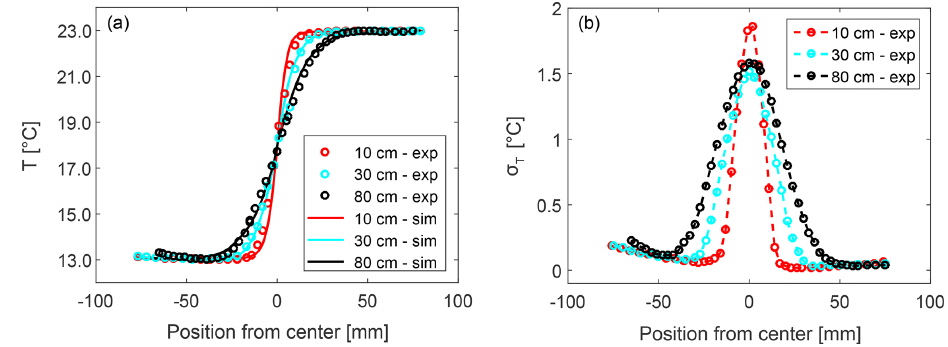
Figure 6. (a) Comparison of experimental temperature profiles (circles) with predictions from the simulations (lines) for z 1 (in red), z 3 (in cyan) and z 8 (in black). (b) Experimental results for temperature fluctuations for z 1 (in red), z 3 (in cyan) and z 8 (in black).